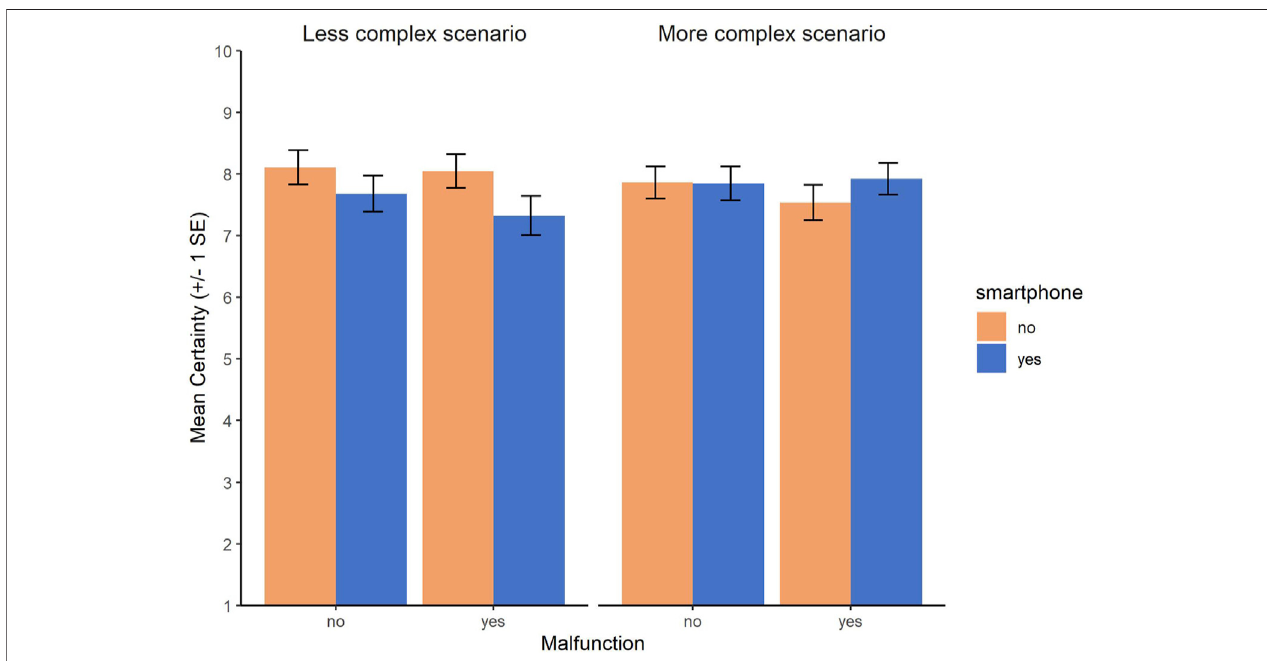
FIGURE4| Decisioncertaintyby systemmalfunction , crossingpedestrian ’ ssmartphoneuse and scenariocomplexity .Errorbarsrepresentstandarderrors.Higher ratings represent a more certain decision. For results of signi fi cance tests, see text.